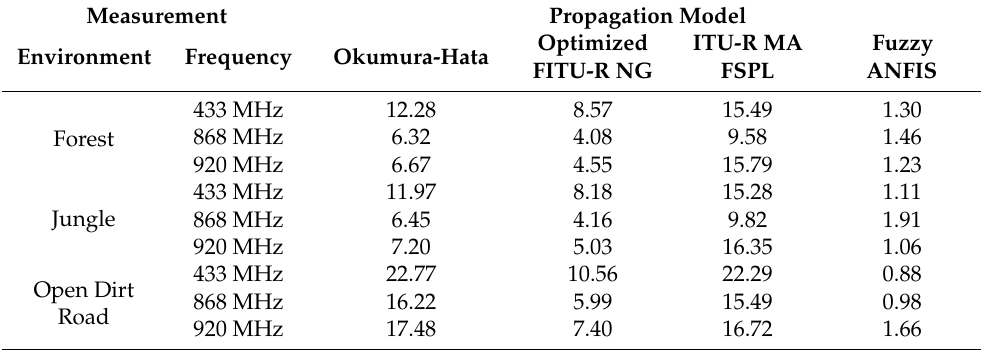
Table 2. Statistical evaluation for each pathloss propagation model using